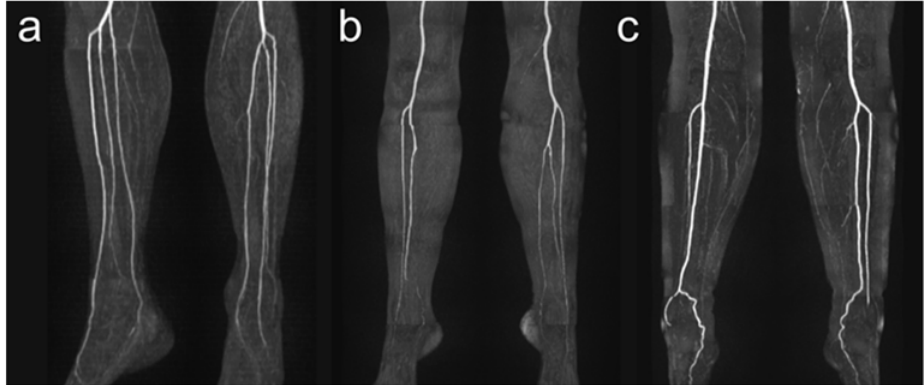
Figure 3. Exemplary illustration of anatomical vessel variations of lower leg arteries. Panel ( a ) shows a type I ‐ C according to Kim et al. [19] with the first exit of the PT below the knee joint with the subsequent exit of FA and AT via a common trunk. Panel ( b ) shows a hypoplastic PT (Type III ‐ A) on the right side, and panel ( c ) shows a hypoplastic PT on both sides. Note the supply to the foot in these cases from the FA.